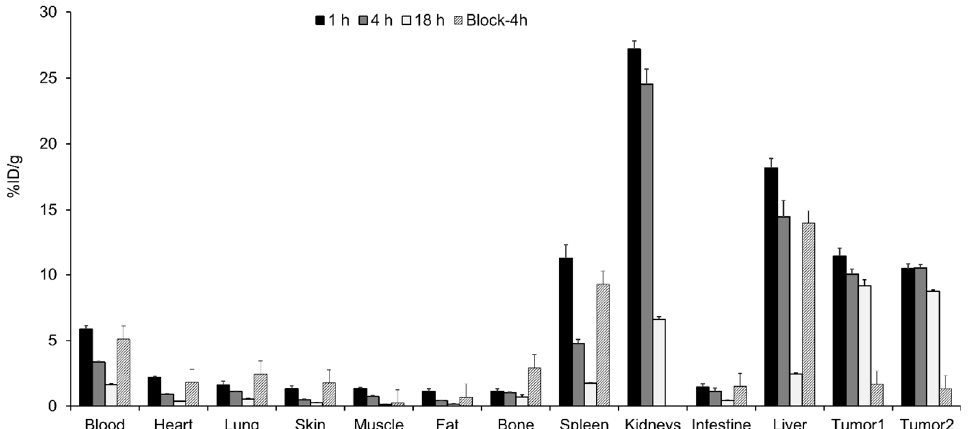
Figure 5. Biodistribution studies of the radioimmunoconjugate 64 Cu-PCB-hnRNP in female nude mice bearing TNBC MDA-MB-231 tumors at different timepoints (Tumor 1 = left-hand side) and (Tumor 2 = right-hand side). An excess blocking dose of hnRNPA2B1 (50 μ g; 19.2-fold) was given prior to administration of 64 Cu-PCB-hnRNP and specificity was evaluated at the 4 h after injection.